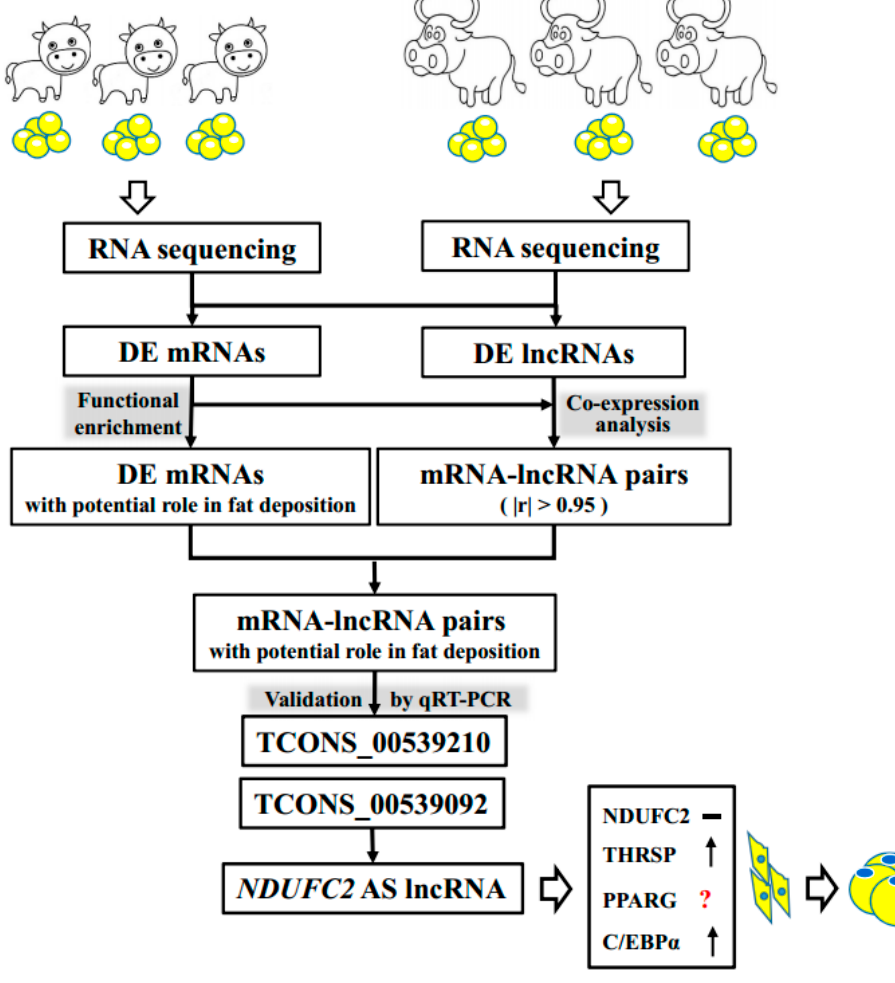
Figure 6. Schematic illustration of the experimental procedure and the main results.